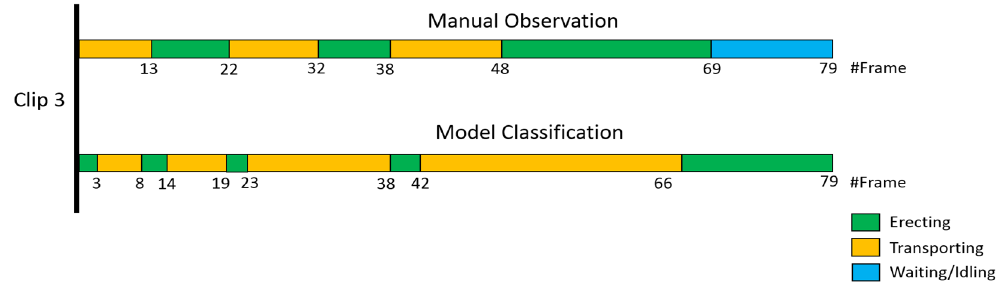
Figure 13. Comparison of workface assessment between manually labeled ground truth and automatically generated results from the model.